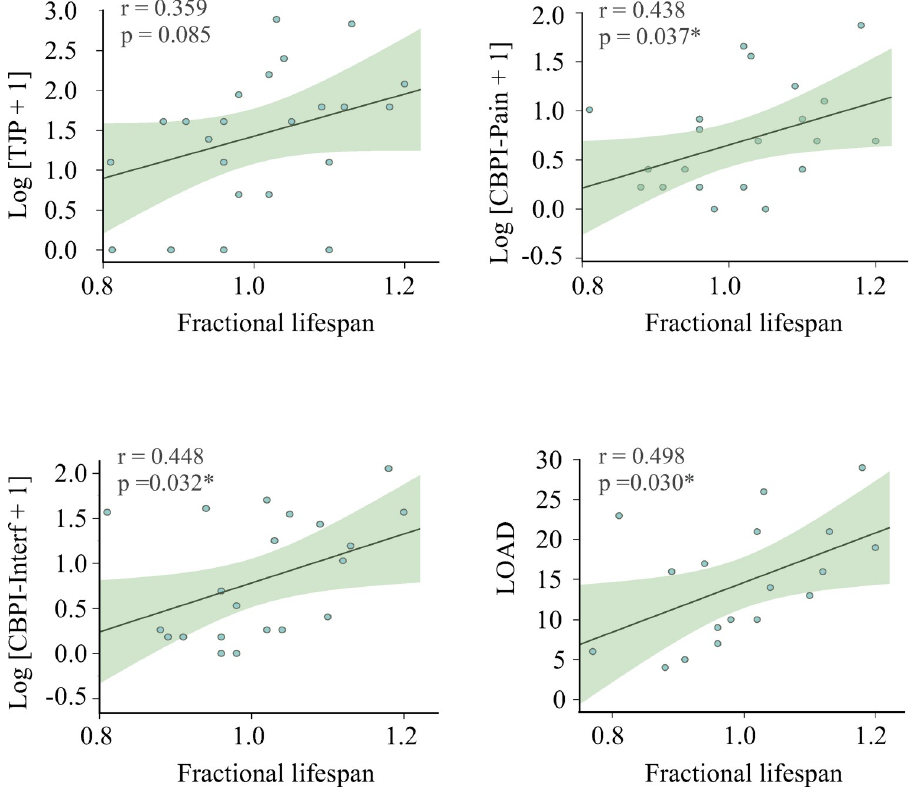
Fig 2. Correlation between fractional lifespan, pain and owner-assessed function evaluation. Pain was assessed by orthopedic examination (total joint pain) and by the Pain Severity subscale of the owner-based questionnaire, the Canine Brief Pain Inventory (CBPI). Additionally, owners’ perception of dogs’ function was evaluated by means of the Pain Interference subscale of the CBPI and the Liverpool Osteoarthritis in Dogs (LOAD) questionnaire. During the orthopedic examination the pain of each joint was graded according to the scale described by Knazovicky et al . (2016) [34] and total joint pain was calculated as the sum of each joint pain score.